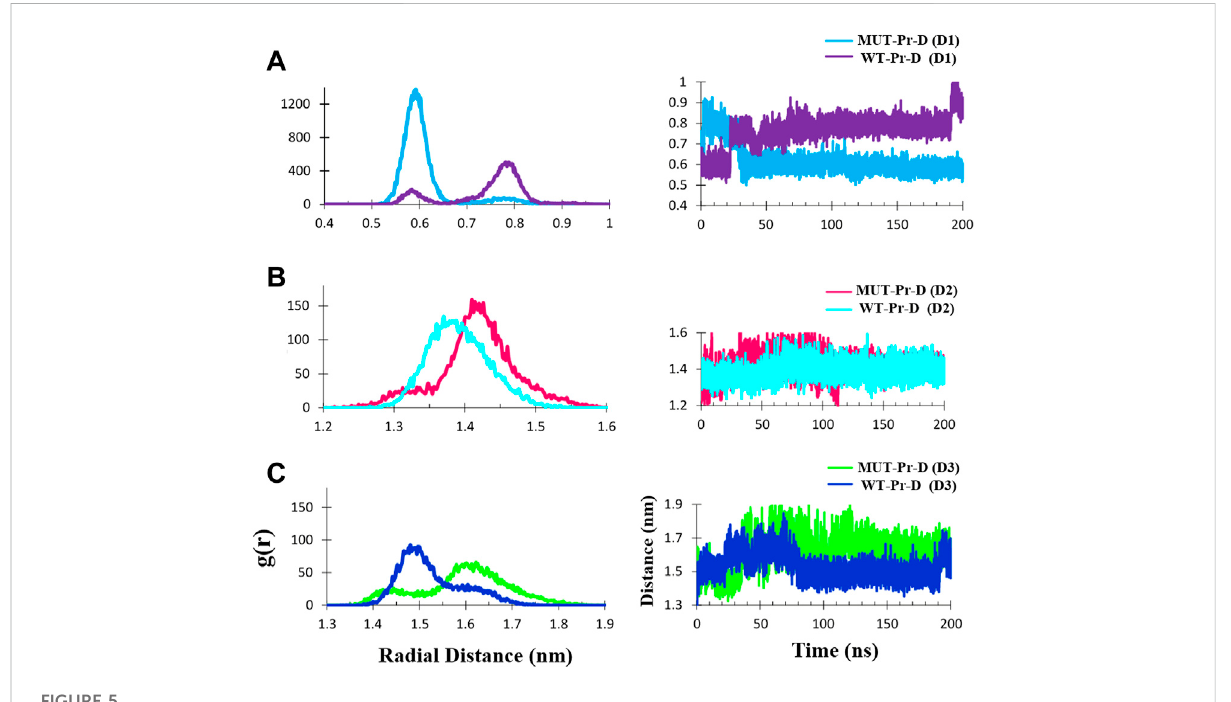
FIGURE 5 TheC α -C α radialdistributionfunctions(RDF)anddistancesduring200 nsMDsimulationforMUT-Pr-DandWT-Pr-DweremeasuredforD1 (A) , D2 (B) , and D3 (C)